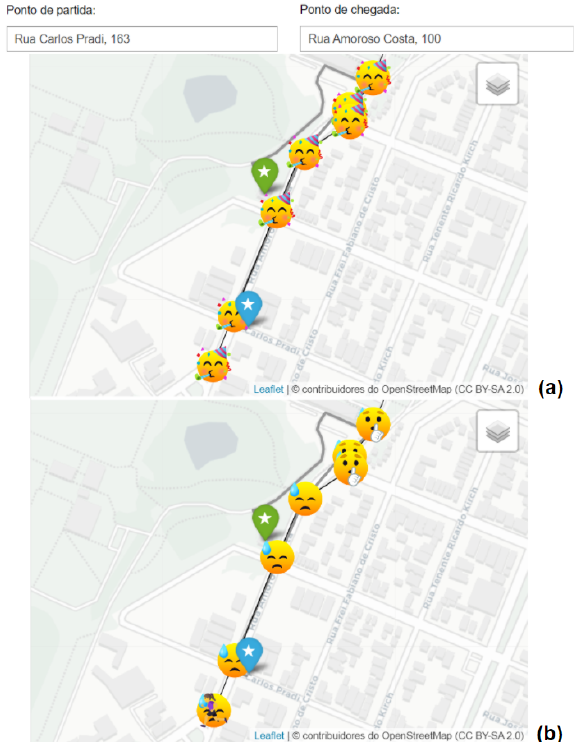
Figure 9 . (a) Negative/neutral emotions of a route between two addresses. (b) Positive emotions of a route between two